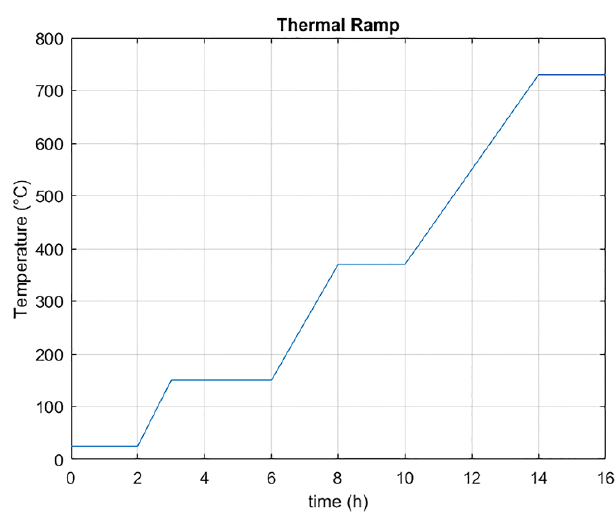
Figure 2. Thermal cycle exploited for shape preparation and model dewaxing.